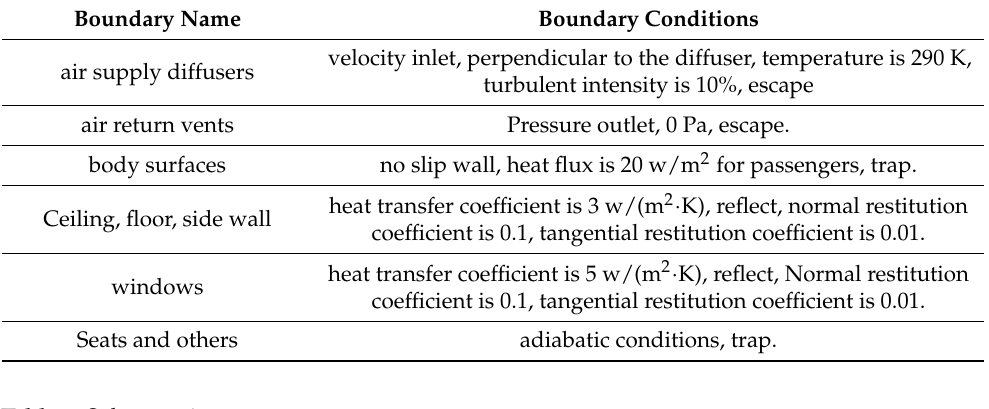
Table 2. Boundary conditions settings.